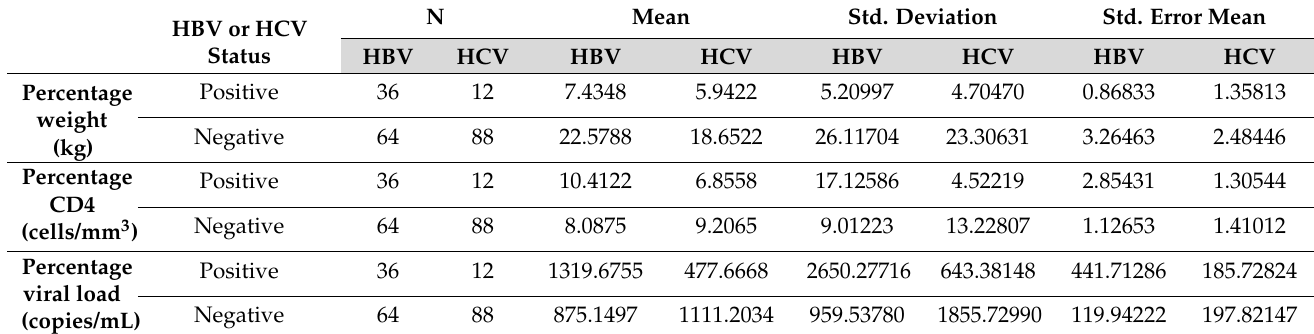
Table 2. Group statistic table for assessment of immune response